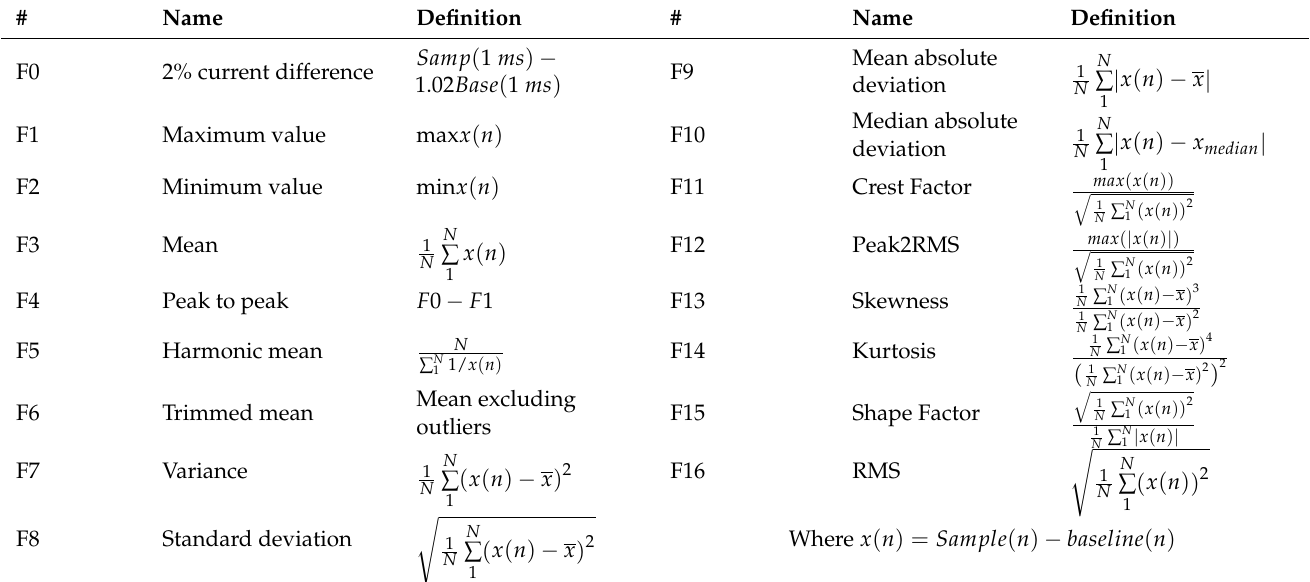
Table 3. List of statistical features extracted from sensor reading that was used to train test machine learning algorithms (ABC, DTC, MLPC, and